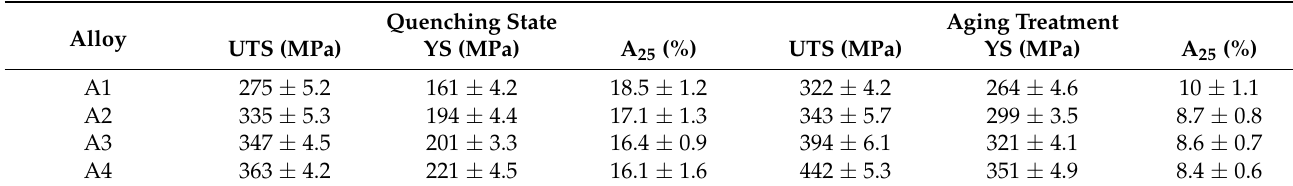
Table 3. Tensile properties of the designed alloys under different conditions.